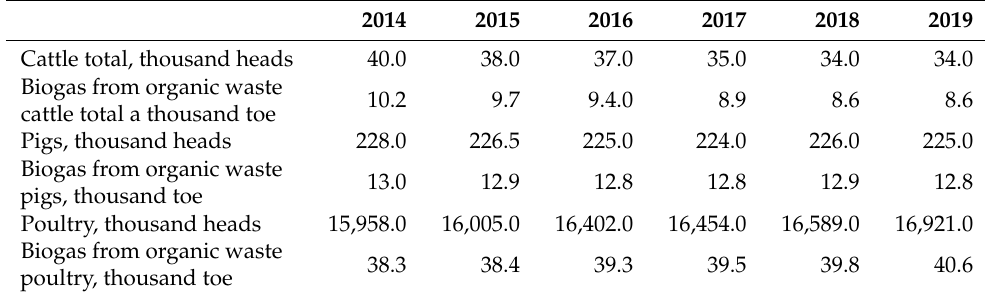
Table 2. The economic potential of biogas from organic waste.